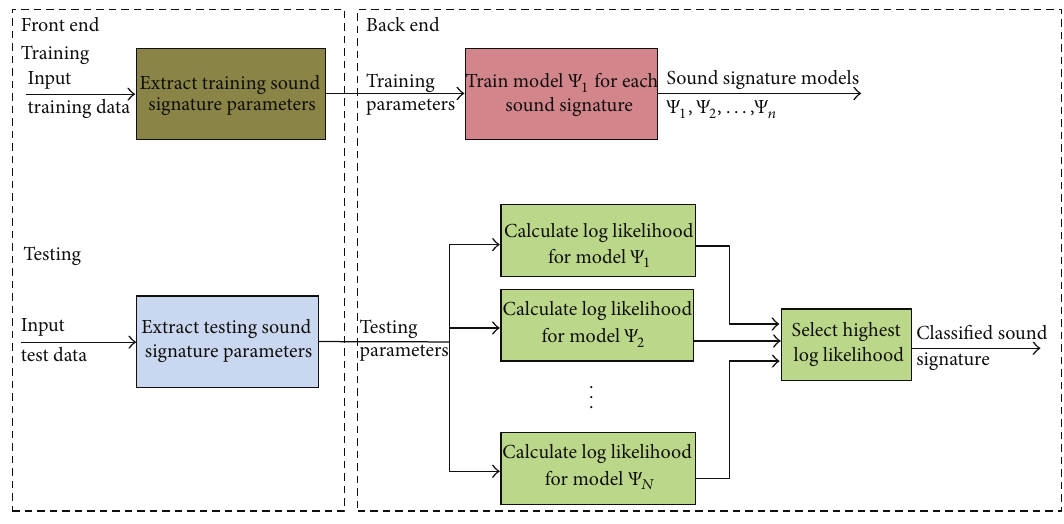
Figure 1: Typical configuration for a “sounds of daily life” classification system, which we refer to herein as the baseline system. Classified sound signatures can then be modelled for telemonitoring